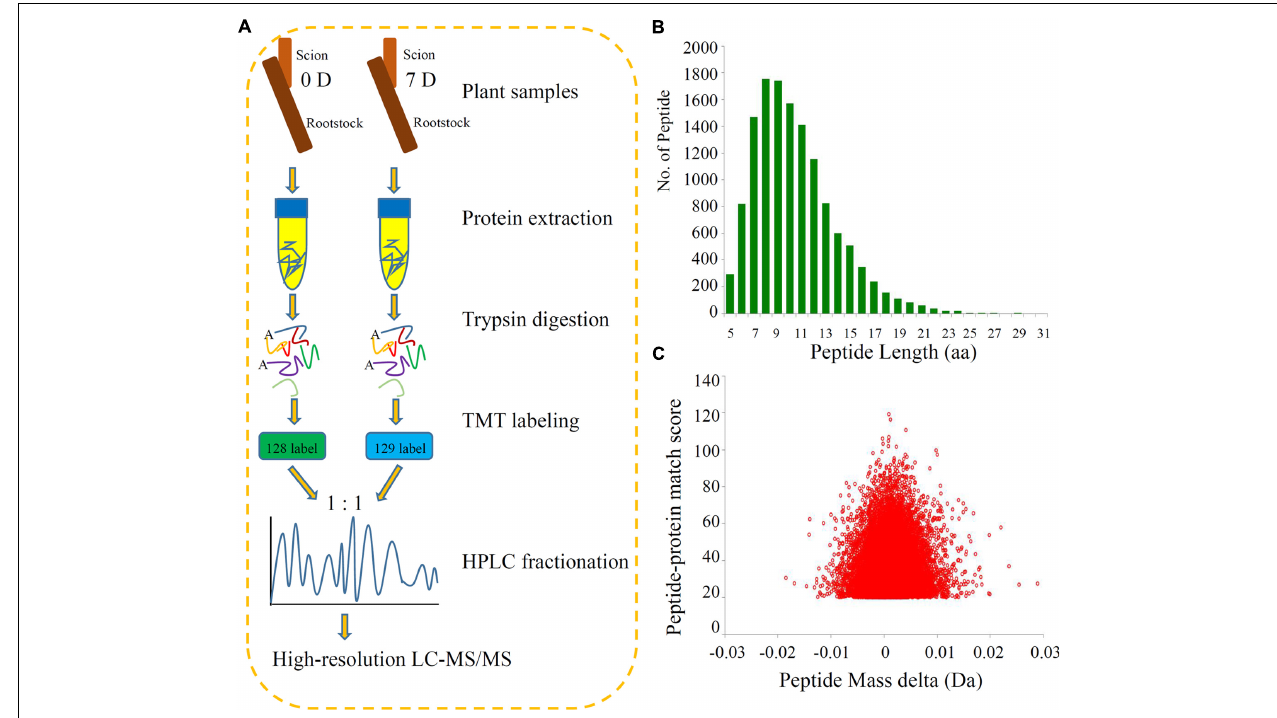
FIGURE 1 | Experimental strategy for the quantitative proteome analysis and QC validation of MS data. (A) Proteins were extracted in three biological replicates per sample and trypsin digested. The resulting peptides were directly analyzed by HPLC-MS/MS. (B) Length distribution of all identified peptides. (C) Mass delta of all identified